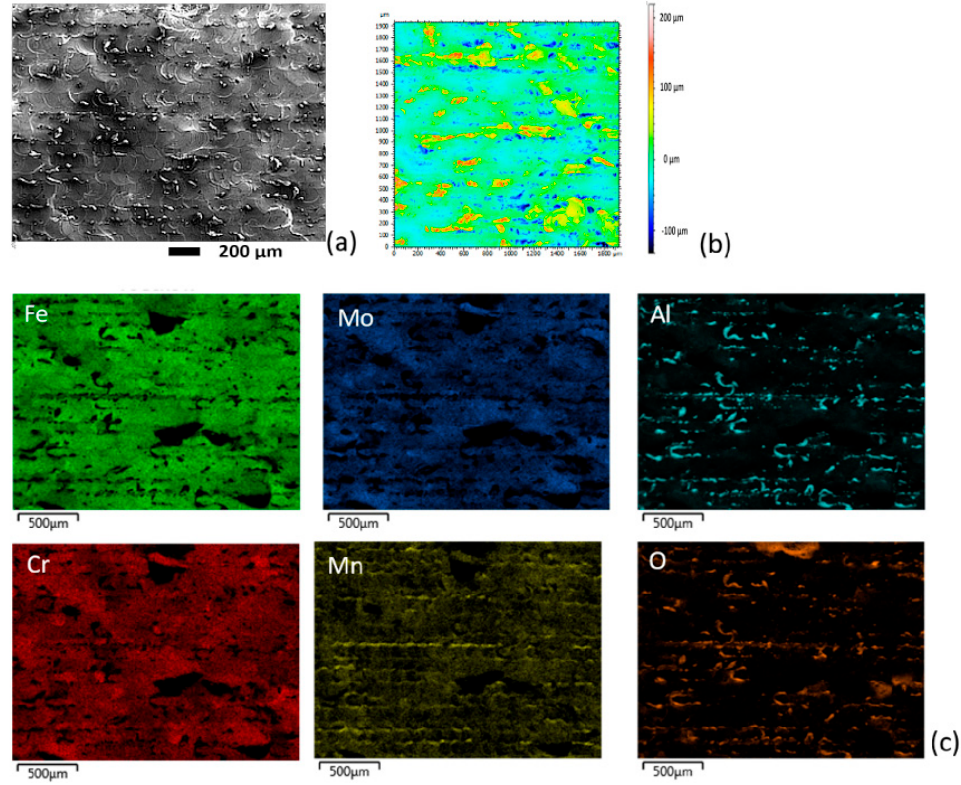
Figure 10. Surface analysis of the sample N° 24 for the laser melting HEAs coating. ( a ) SEM micrography, ( b ) topographical measure ( c ) EDS analysis.